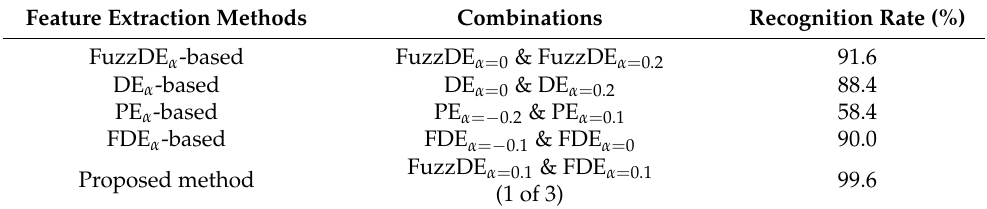
Table 3. Highest classification recognition rates for each feature extraction method (double features).